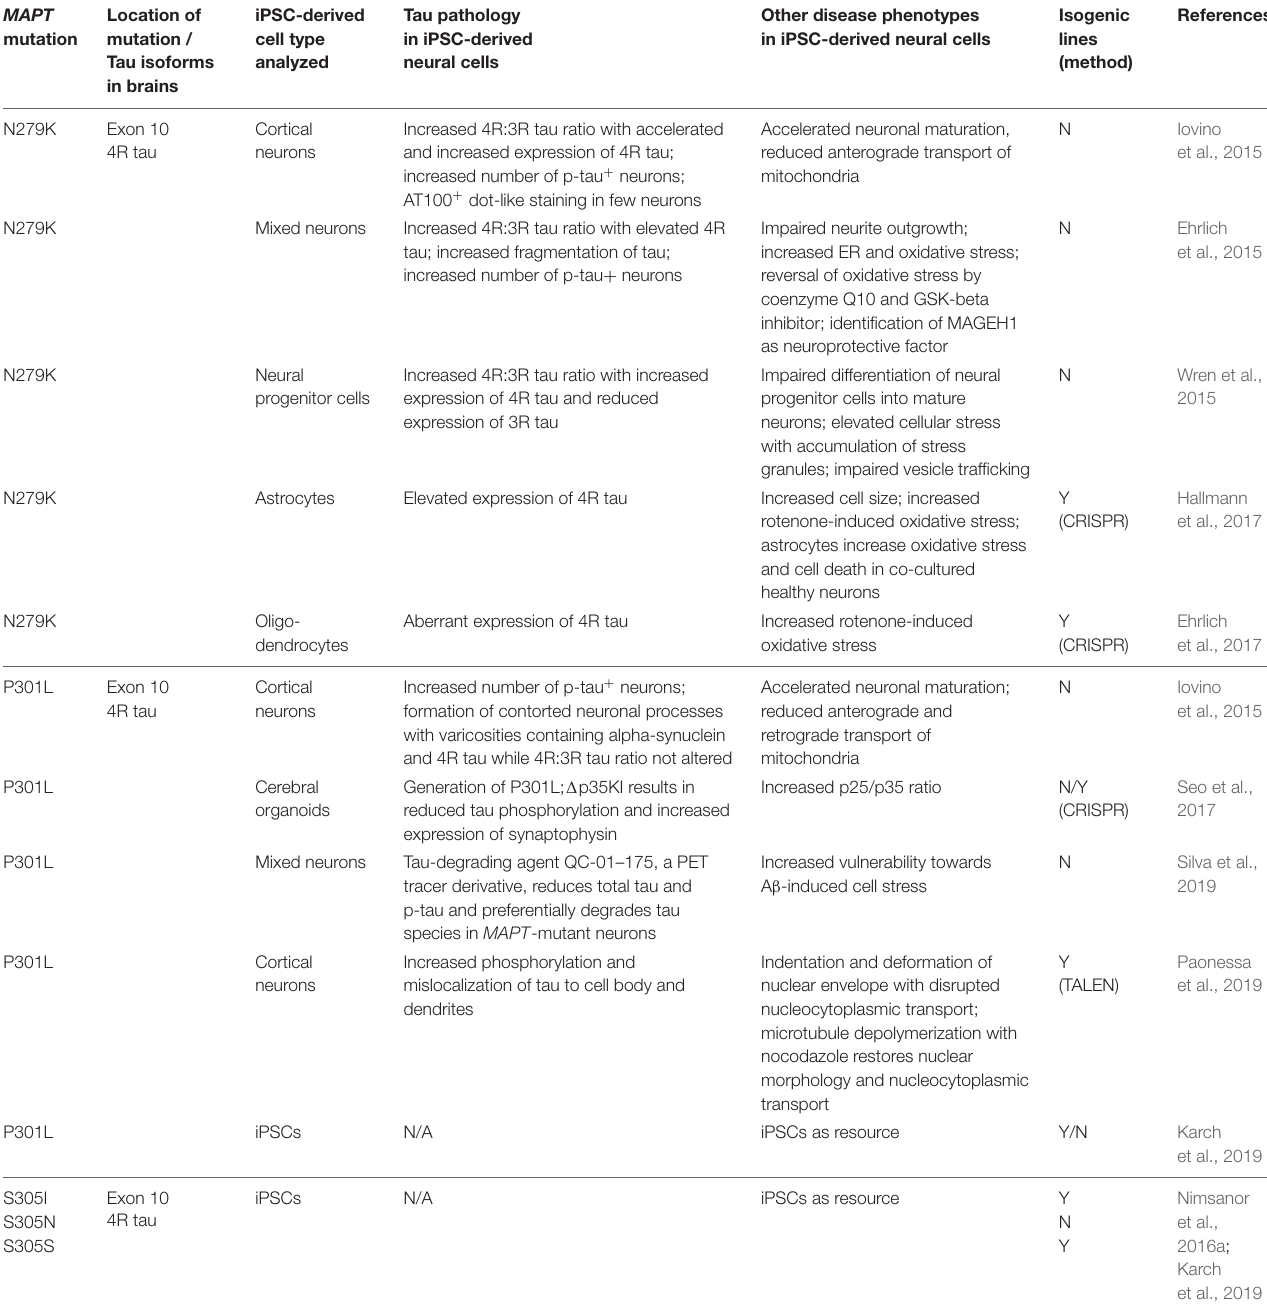
TABLE 1 | Induced pluripotent stem cell models of FTLD-tau linked to MAPT mutations in exon 10. MAPT Location of mutation mutation